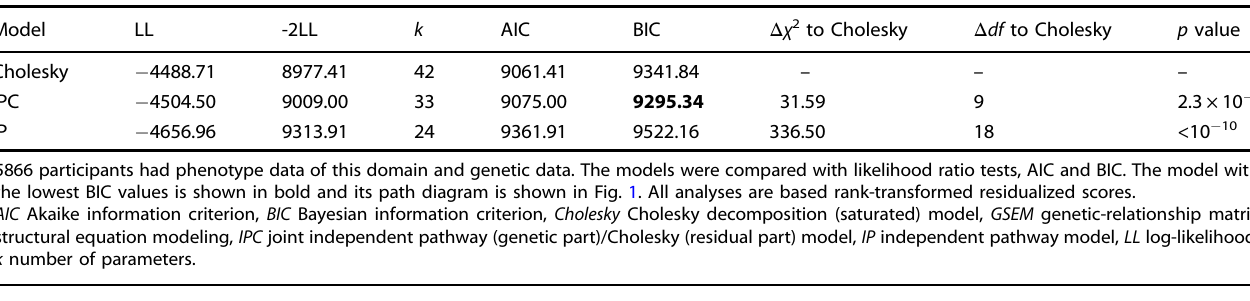
Table 2. Single-domain GSEM model fi t comparisons of reading fl uency. Model